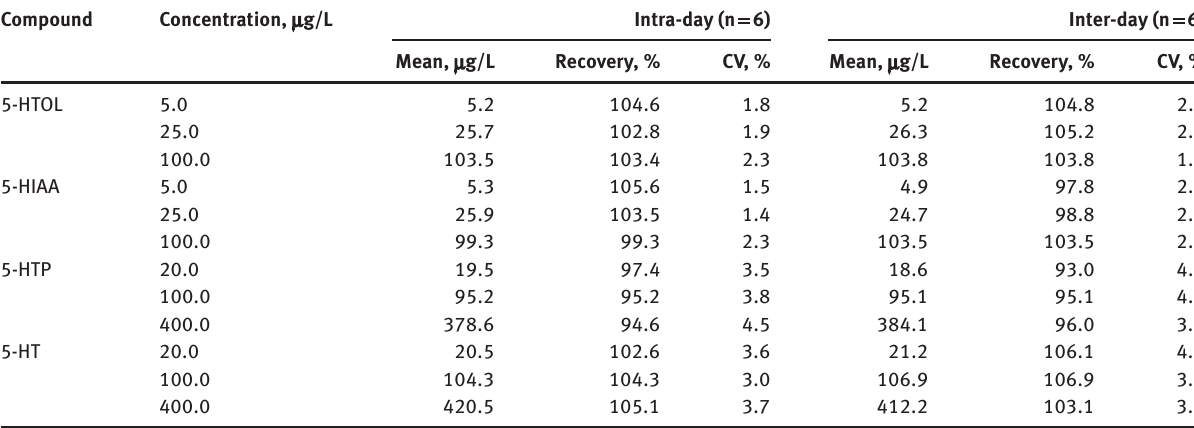
Table 1: The recovery and coefficient of variation (CV) in CSF of GC-MS analysis. Compound